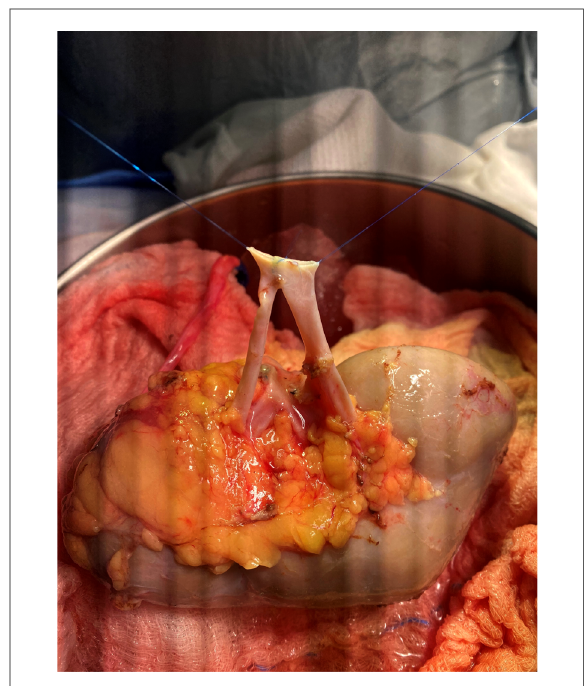
FIGURE 2 Adult allograft with three renal arteries, the lower pole RA was anastomosed end-to-side to the main RA (white arrow), and an upper pole RA end-to-side to a branch of the main RA inside the hilum (black arrow). RA, renal